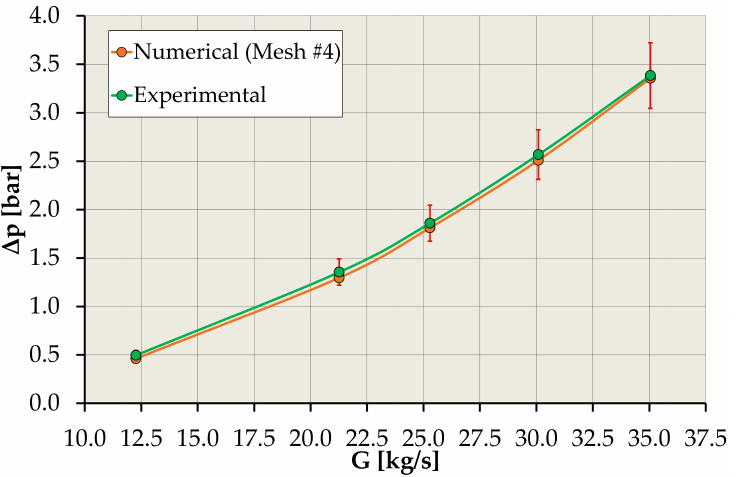
Figure 13. Numerical and experimental characteristic curves of the OVT mock-up cooling